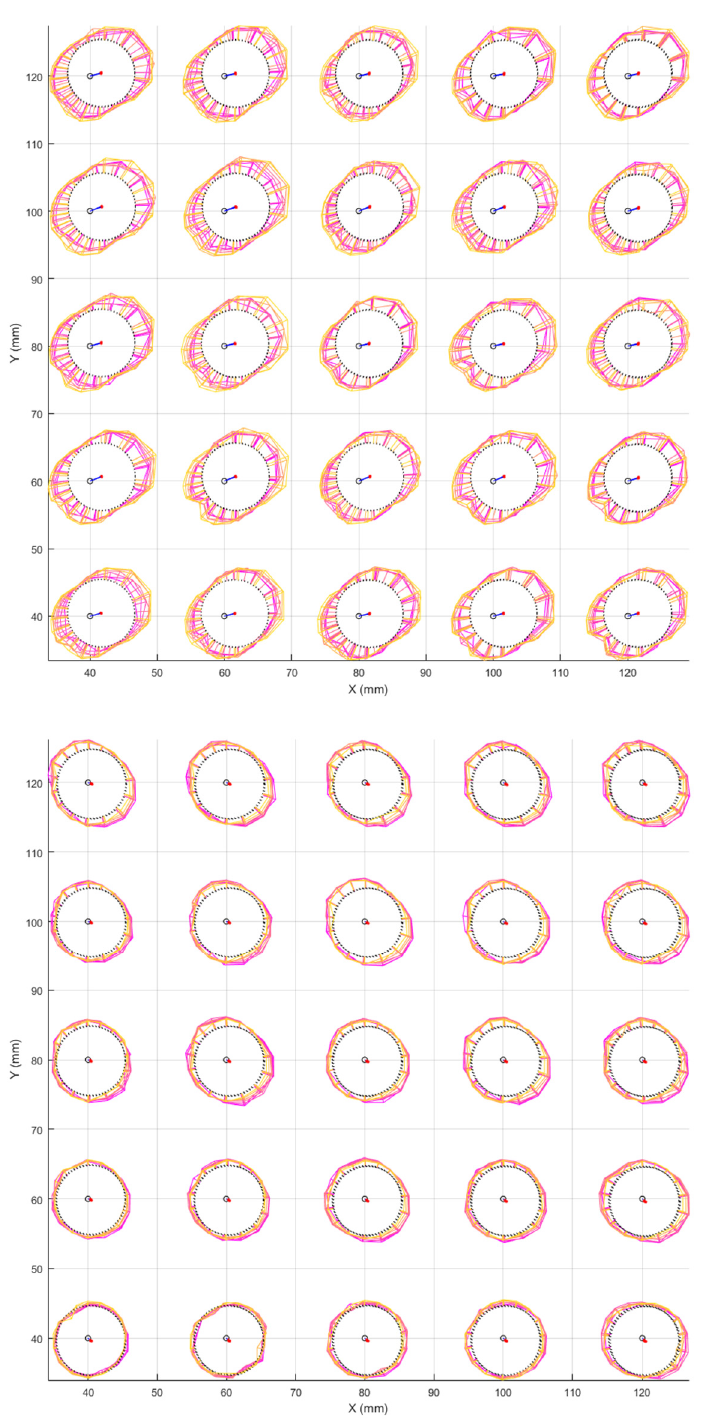
Figure 21. Results from position 2:20× radial error exaggeration, 2× hole position exaggeration. (top) without compensation; (bottom) with compensation.